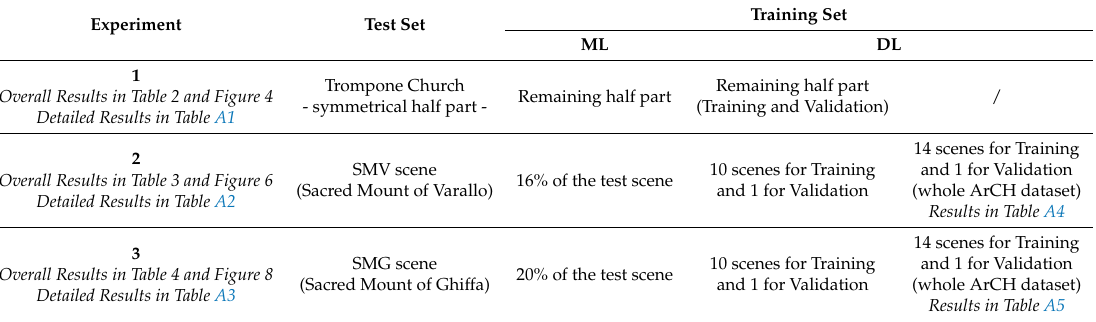
Table 1. Experiments performed with relative test and training